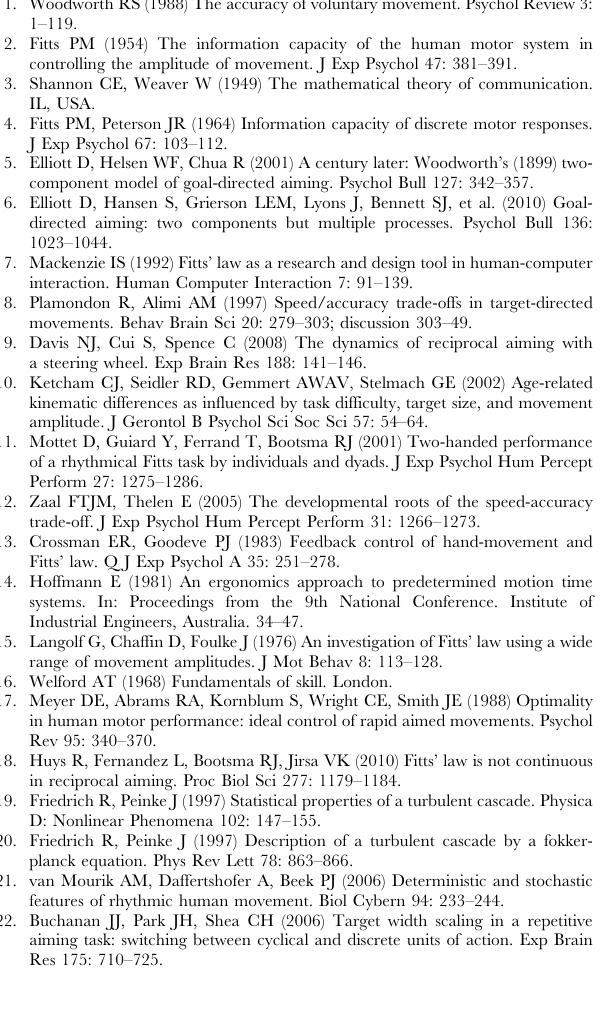
Table S1 Details of the experimental conditions used in experiment 1. Table S2 Details of the experimental conditions used in experiment